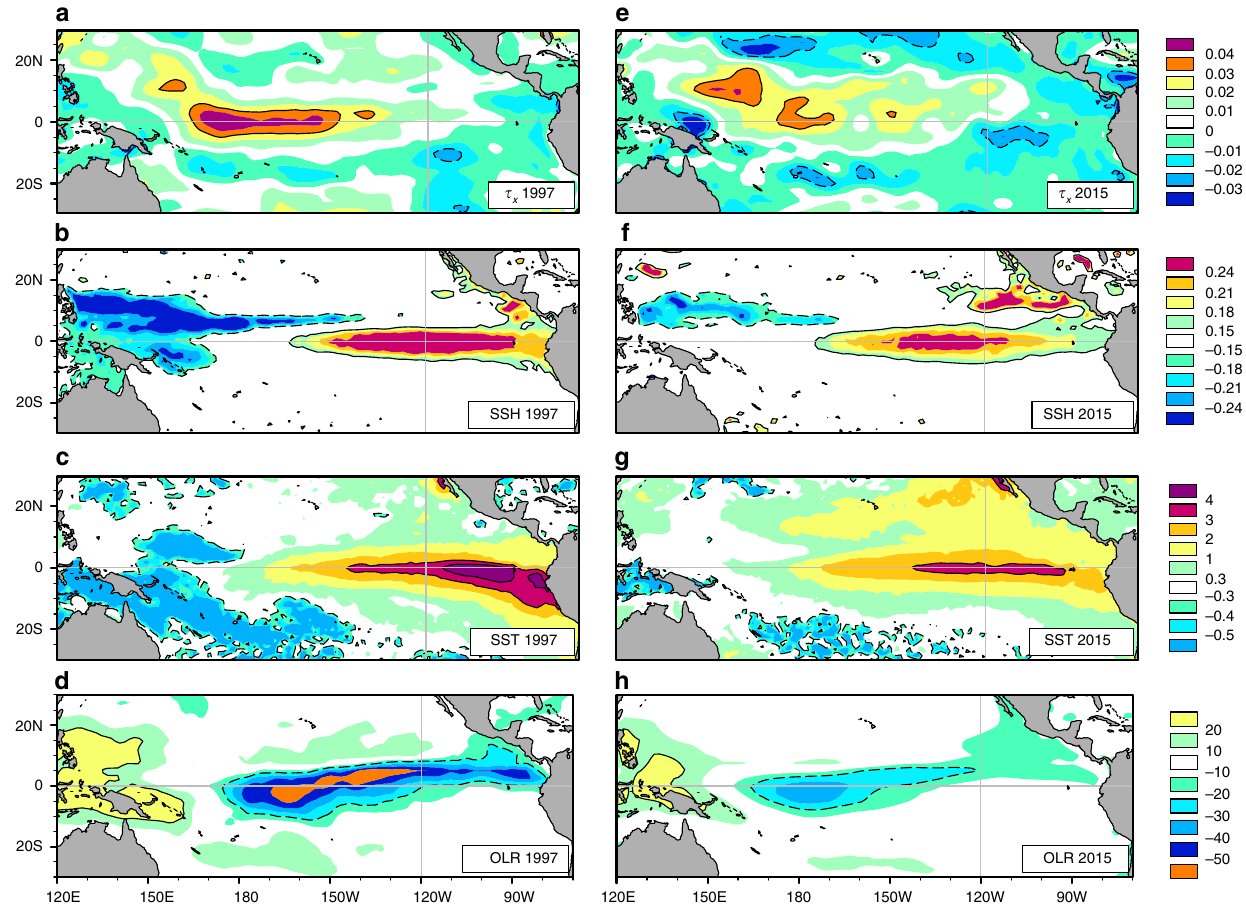
Fig. 10 Climate anomalies during the 1997 and 2015 El Niños. The strong eastern-ocean intensi fi ed structure of SST and SSH anomalies in 1997 ( b , c ) contrast with the eastern-ocean damped variations in 2015 ( f , g ). Anomalies of zonal surface wind stress ( τ x ) ( a , e ) and OLR ( d , h ) are also shown. Further, an elongated, off-equatorial band of enhanced SSH and SST anomalies is seen stretching west from Baja California and Mexico in 2015; this is markedly absent in 1997. Jacox et al. 63 further contrast the nature of coastal southern California ’ s SSH anomalies during 1997 and 2015. The absence of strong far- eastern Paci fi c SST anomalies in 2015 is re fl ected in the lack of negative OLR anomalies over this region — this may be linked to the many failed rainfall forecasts for Peru and southern California 64 during the winter of 2015/16. Further details of the differences during the two El Niños may be found in Xue and Kumar 49 . All data were averaged from October to December — this season corresponds to the peak of SST anomalies during 2015 49 . The maps in the fi gure were rendered with the NCAR Command Language software (https://doi.org/10.5065/D6WD3XH5) from the Global Self-consistent, Hierarchical, High-resolution Geography Database (GSHHG). The GSHHG is available online at